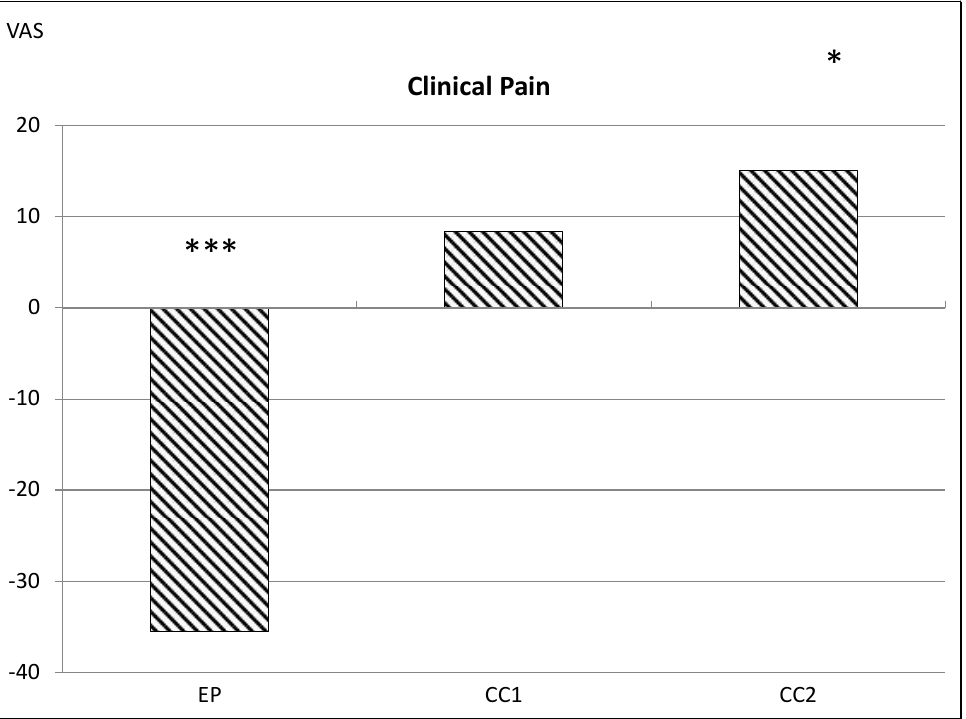
Figure 4. Changes in clinical pain intensity in response to 2, ≈8 min EP, CC1 and CC2 protocols assessed by visual analogue scale (0 – 100). * p < 0.05, *** p < 0.001 comparing pre- vs.